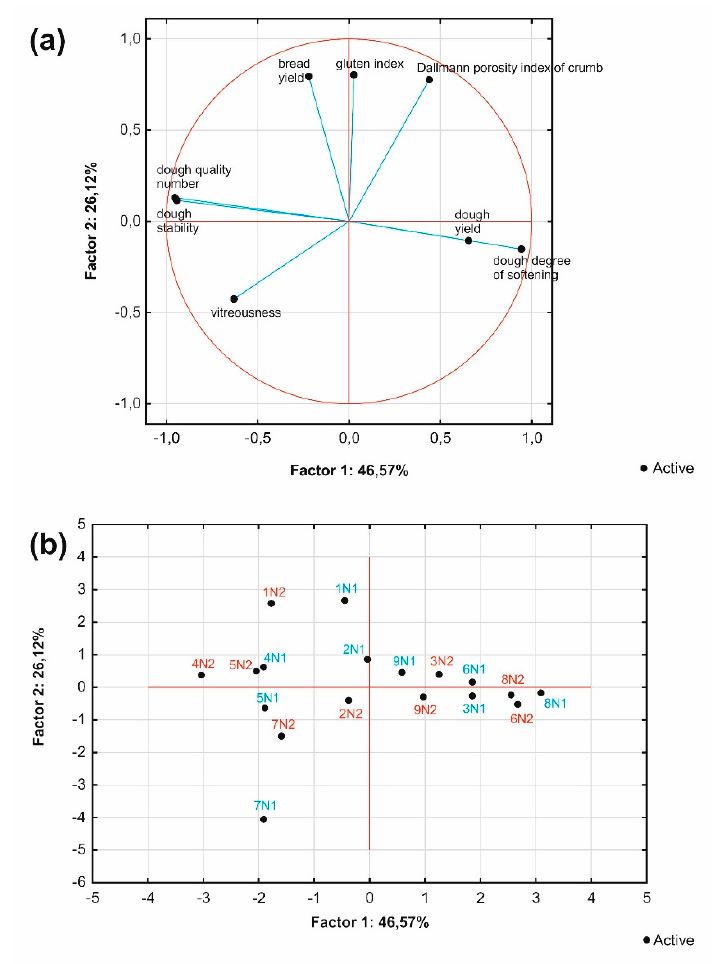
Figure 3. Principal components analysis of ( a ) distribution of the analyzed parameters ( b ) distribution of wheat cultivars and nitrogen fertilisation. 1—Hybery. 2—Hyena. 3—Hyfi. 4—Hyking. 5—Hymalaya. Table 6. Value of principal components coe ffi